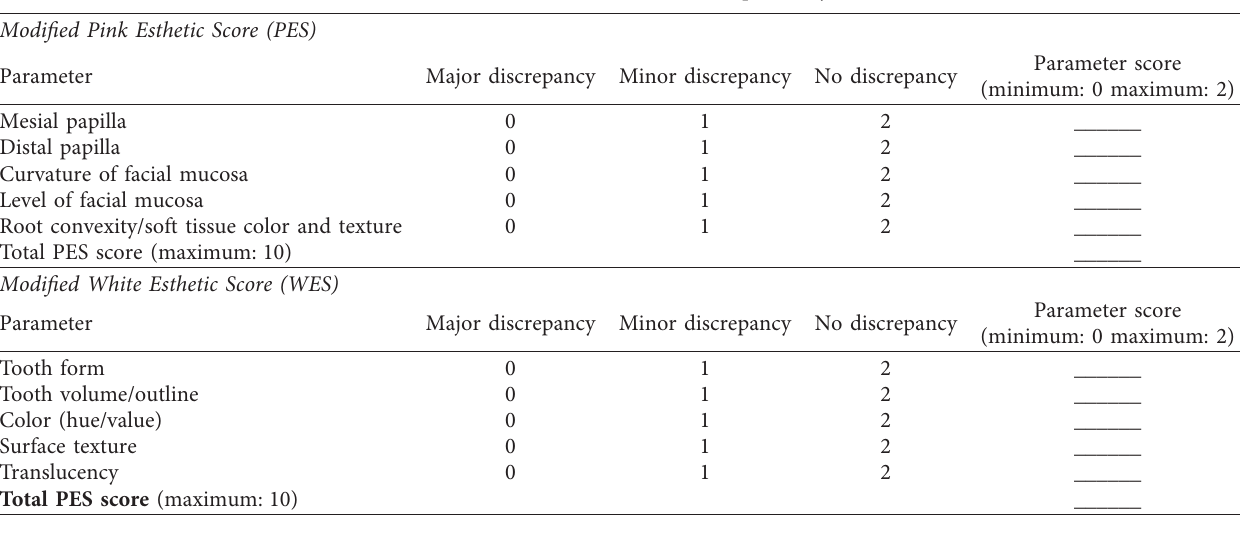
Table 2: Pink and White Esthetic Score sheets as interpreted by Belser et al.